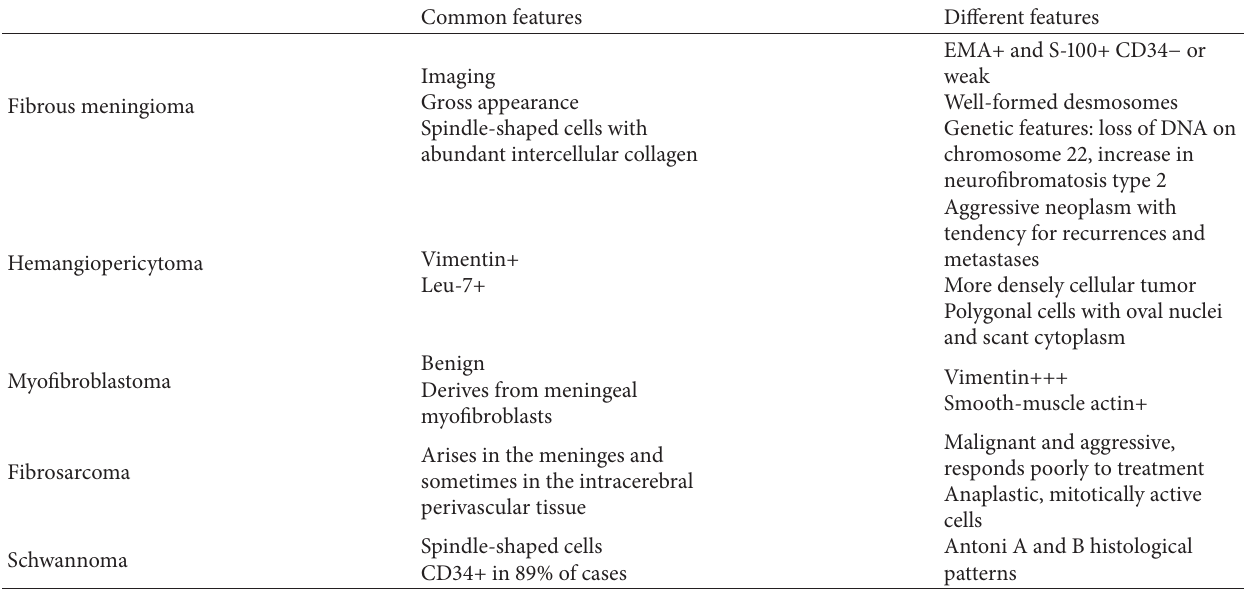
Table 2: MSFT and other dural-based tumors: common and distinctive